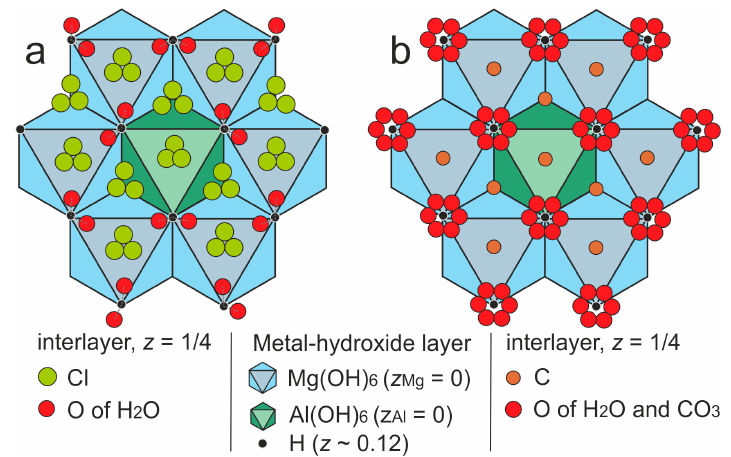
Figure 6. Projections of the crystal structure of chlormagaluminite: ( a ) general view; ( b ) hexagonal stacking sequence of metal-hydroxide layers; ( c ) ordering of Mg and Al according to 3 3 × superstructure; ( d ) interlayer superimposed to metal-hydroxide layer.